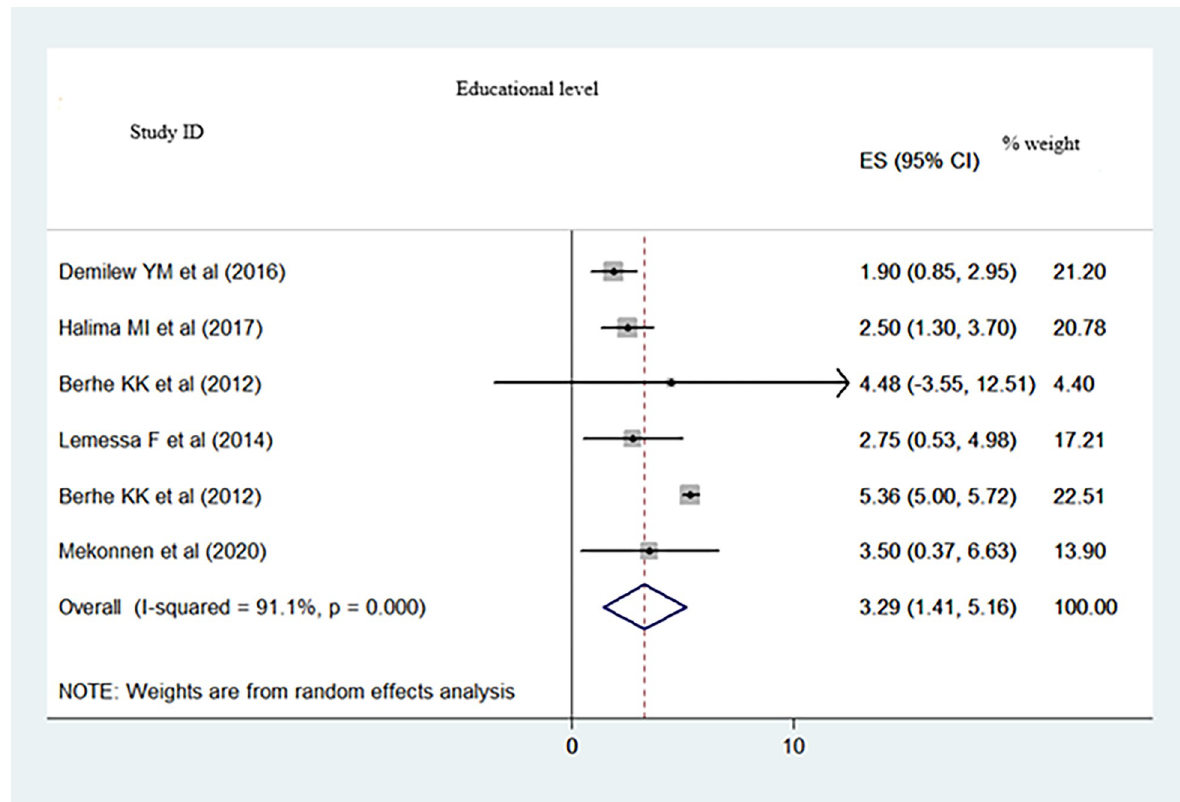
Fig 5. A meta-analysis of educational level associated with dietary adherence among type 2 DM population in Ethiopia.